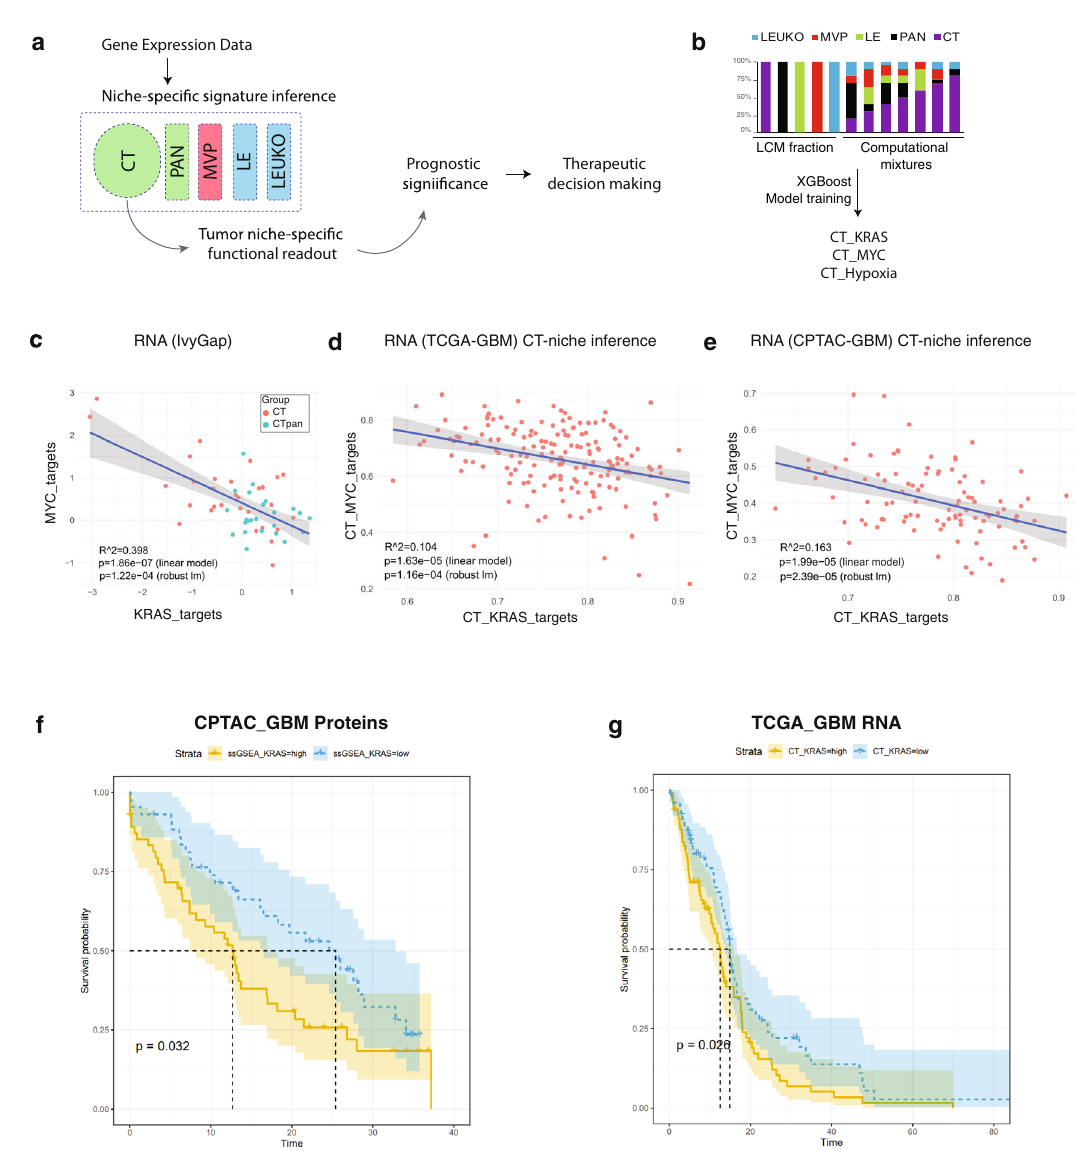
Fig. 5 High levels of the “ KRAS targets ” signature is associated with clinical aggressiveness in GBM patients. a Schematic depicting non-tumour tissue content in fl uencing overall molecular signatures and how computational methods that allow for niche-speci fi c inference may lead to robust actionable insights. b A synthetic dataset was built from pathologically de fi ned leading edge (LE), cellular tumor (CT), palisading cells around necrosis (PAN), and microvascular proliferations (MVP) tissue samples by generating computationally simulated mixtures; this dataset was used to train XGBoost models to infer the KRAS targets, MYC targets and hypoxia signatures in a CT-niche speci fi c manner. c Association between KRAS and MYC target signatures in the RNA Ivy Gap dataset ( n = 54). Null hypothesis testing was performed by permuted linear model fi t analysis. The 95% con fi dence interval is shown as grey areas. d CT-niche-speci fi c inference in the TCGA-GBM dataset ( n = 171). Null hypothesis testing was performed by permuted linear model fi t analysis. The 95% con fi dence interval is shown as grey areas. e CT-niche-speci fi c inference in the CPTAC-GBM dataset ( n = 100). Null hypothesis testing was performed by permuted linear model fi t analysis. The 95% con fi dence interval is shown as grey areas. f Kaplan-Meier survival curves for samples split into “ high ” and “ low ” KRAS targets activity using ssGSEA of CT-niche speci fi c inference in a proteomics dataset (CPTAC) and ( g ) at the RNA level (TCGA- GBM). Source data are provided as a Source Data fi